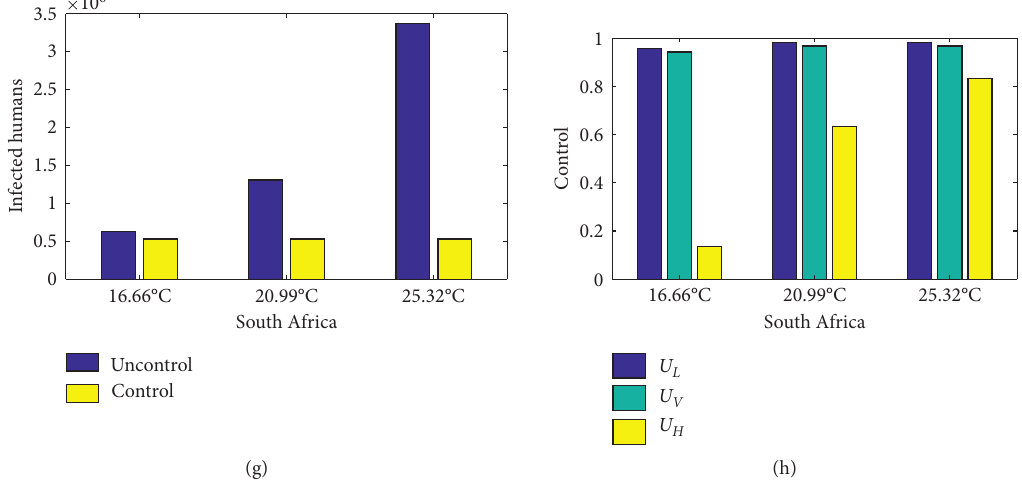
Figure 11: Simulations of the malaria model (2) as a function of time in temperature ranges suitable for mosquitoes: (a, c, e, g) the monthly total number of infected humans with control and (b, d, f, h) optimal controls u H ( t ) ,u L ( t ) , and u V ( t ) , in West, Central, East, and South Africa.